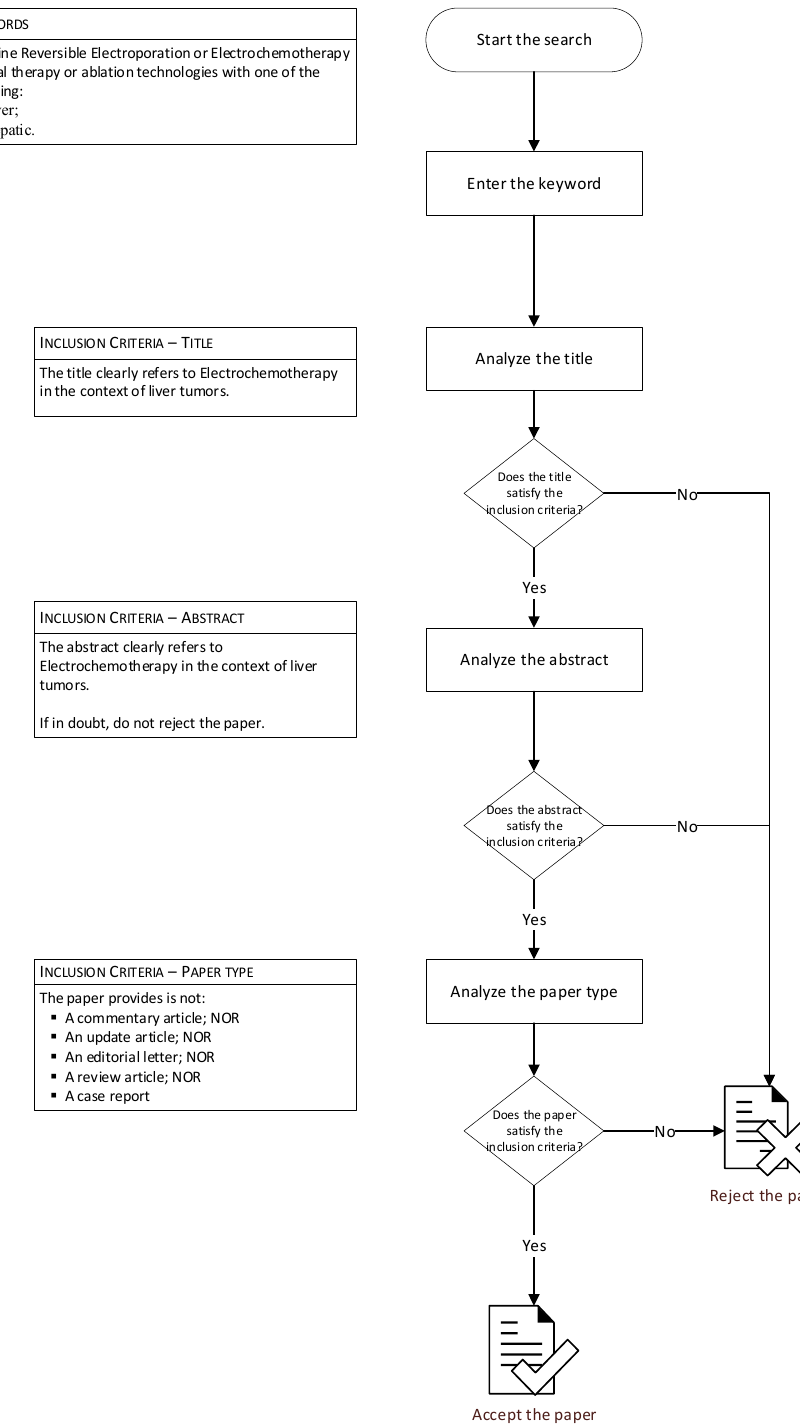
Figure 1. Flowchart of research methods.